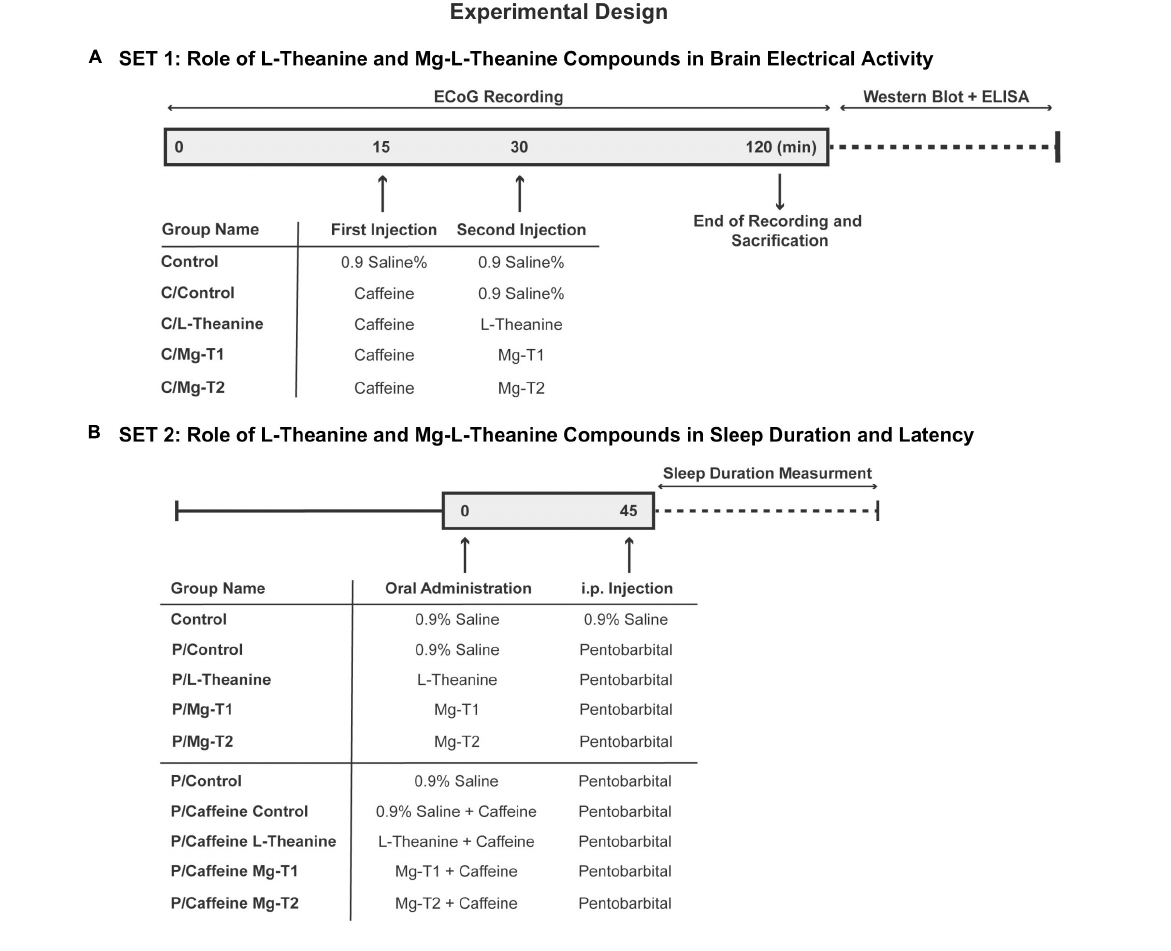
United States). Using the Trans-Blot TurboTransfer